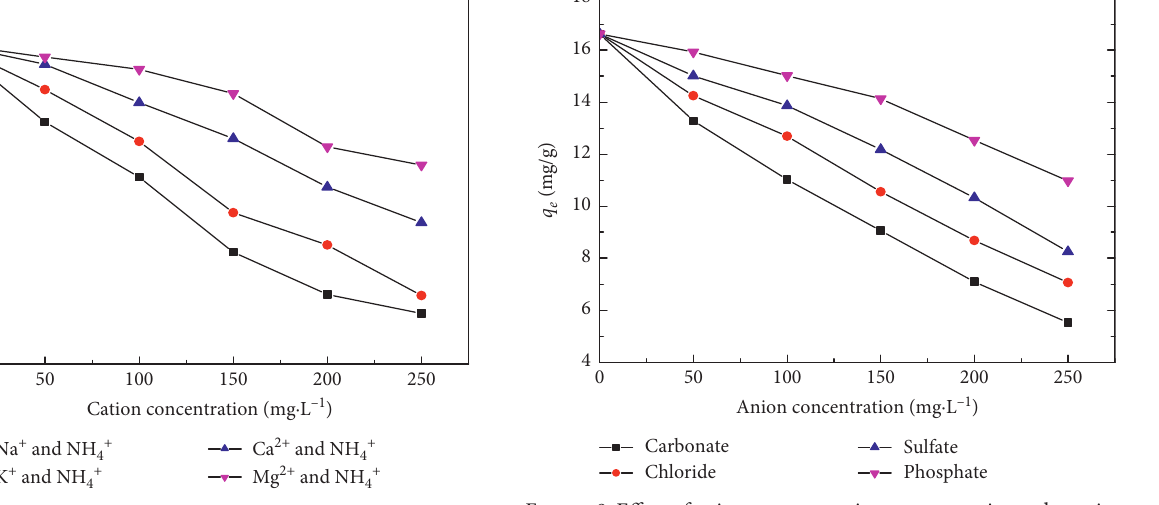
Figure 7: Effect of cations concentration on ammonium ad- sorption (EMRZ dosage � 0.2 g/100mL; contact time � 100min; pH value � 8.0; initial ammonium concentration � 100mg/L; temperature � 25 ° C).